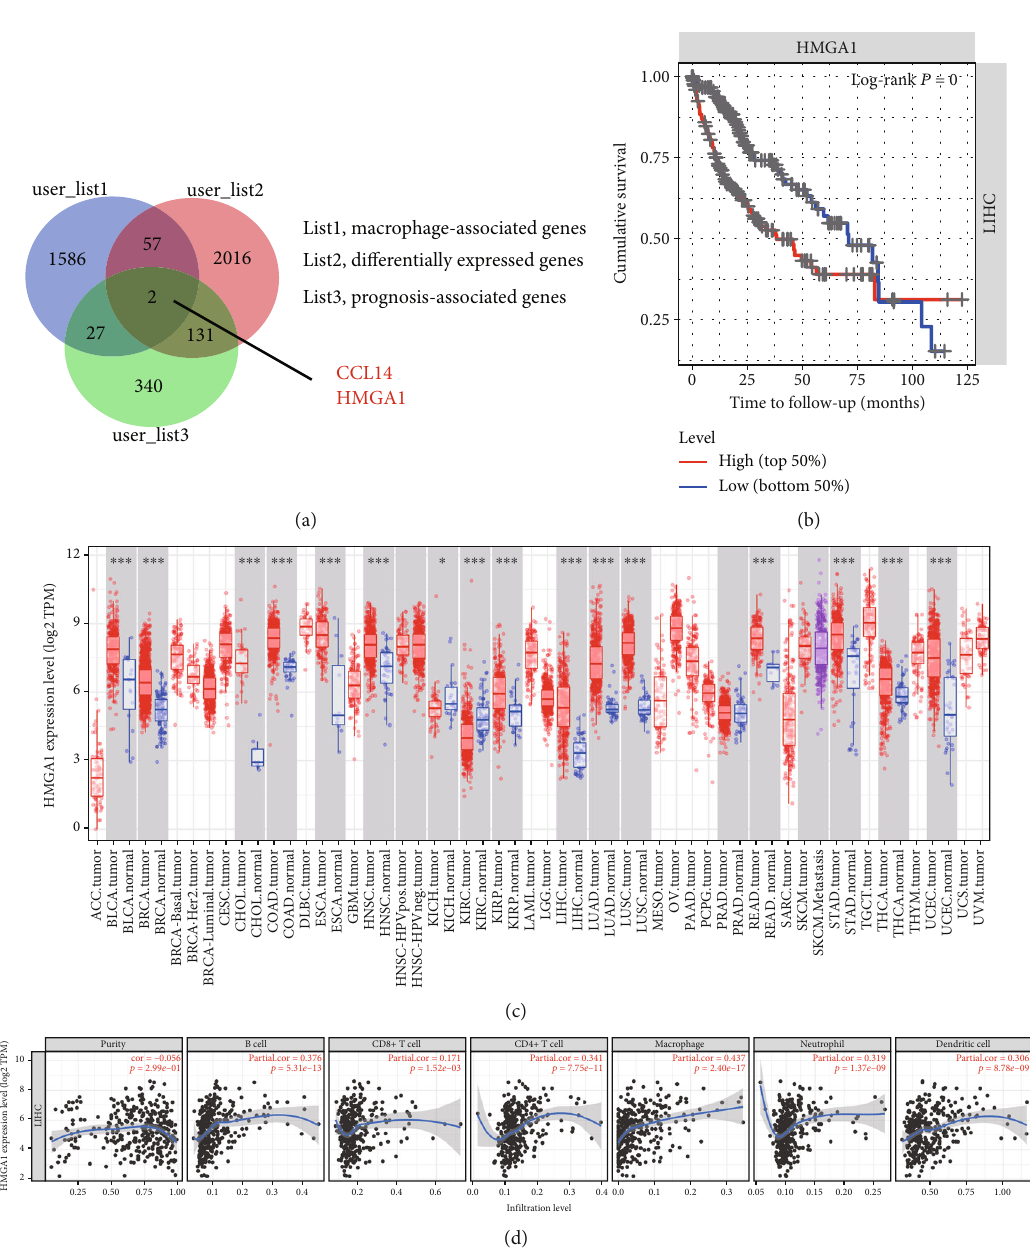
Figure 1: HMGA1 expression is associated with macrophage in fi ltration in HCC. (a) Venn diagram showed the macrophage-associated genes, di ff erentially expressed genes (DEGs), and prognosis-associated genes in HCC. (b) The Kaplan-Meier curve showed the prognostic value of HMGA1 in HCC; data were obtained from the TCGA cohort and the median value of HMGA1 was set as a cuto ff ; high group ( n = 182 ) and low group ( n = 182 ). (c) The pan-cancer expression pattern of HMGA1 in tumor tissue and corresponding nontumor tissues was acquired from the TIMER database (https://cistrome.shinyapps.io/timer/). ACC = adrenocortical carcinoma; BLCA = bladder urothelial carcinoma; BRCA = breast invasive carcinoma; CESC = cervical squamous cell carcinoma and endocervical adenocarcinoma; CHOL = cholangiocarcinoma; COAD = colon adenocarcinoma; DLBC = lymphoid neoplasm di ff use large B-cell lymphoma; ESCA